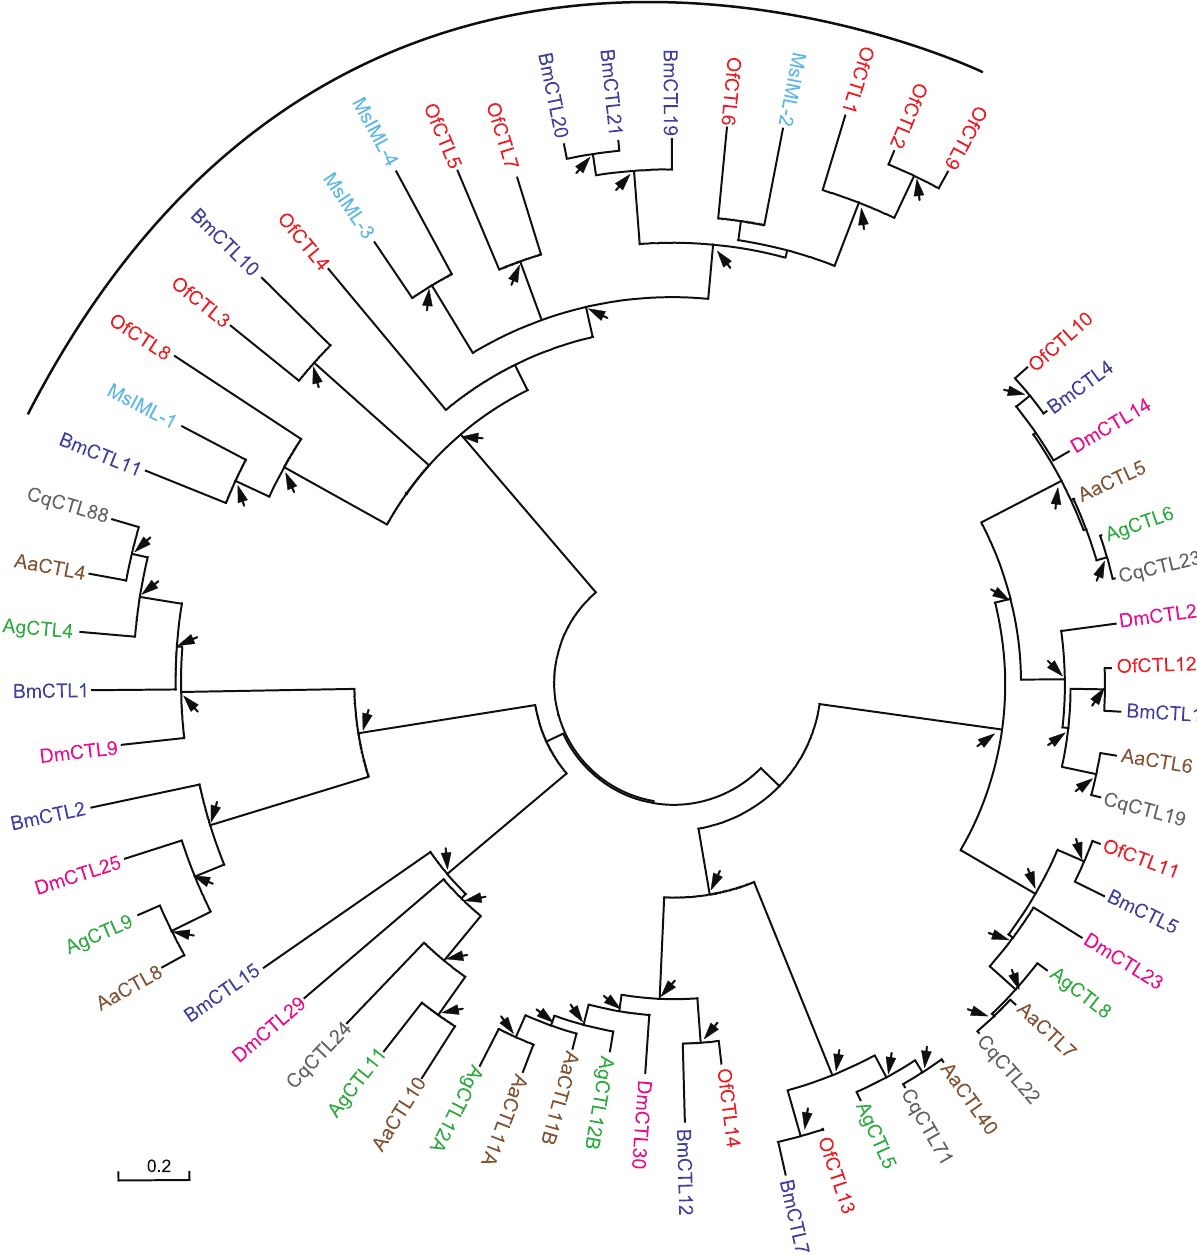
Figure 5. Phylogenetic analysis of C-type lectins (CTLs). The amino acid sequences of 61 CTLs from Ostrinia (Of, red), Drosophila (Dm, pink), Anopheles (Ag, green), Aedes (Aa, brown), Culex (Cq, grey), Bombyx (Bm, purple), and Manduca (Ms, blue) were examined. Lepidopteran-specific CTLs are indicted with bracket. For explanation of the arrows see Fig. 6.